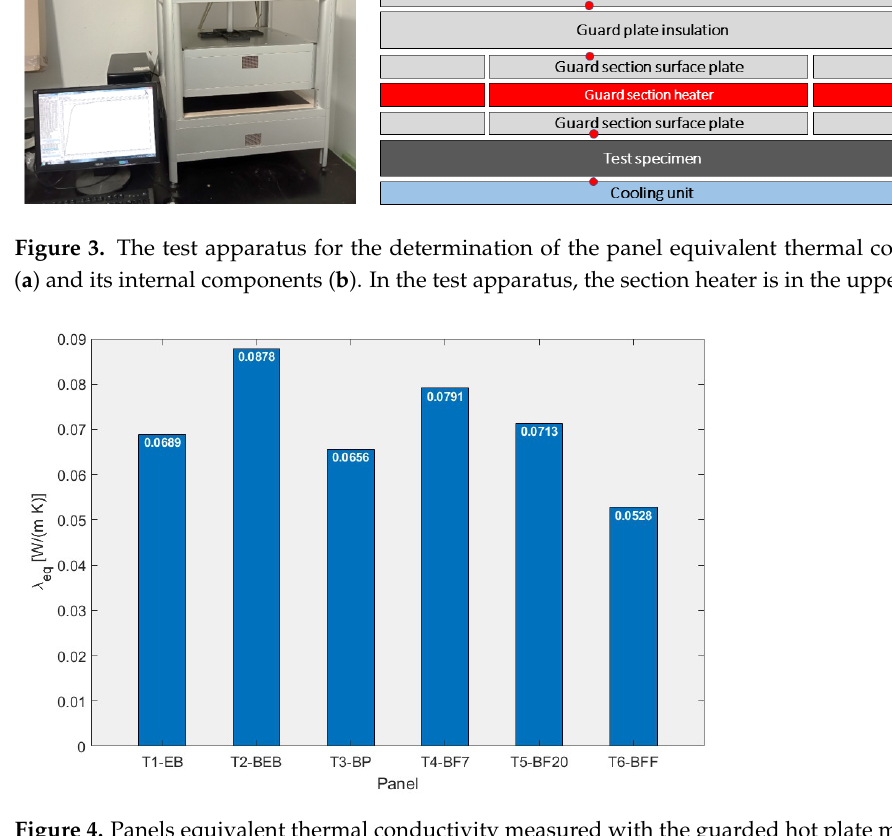
Figure 4. Panels equivalent thermal conductivity measured with the guarded hot plate